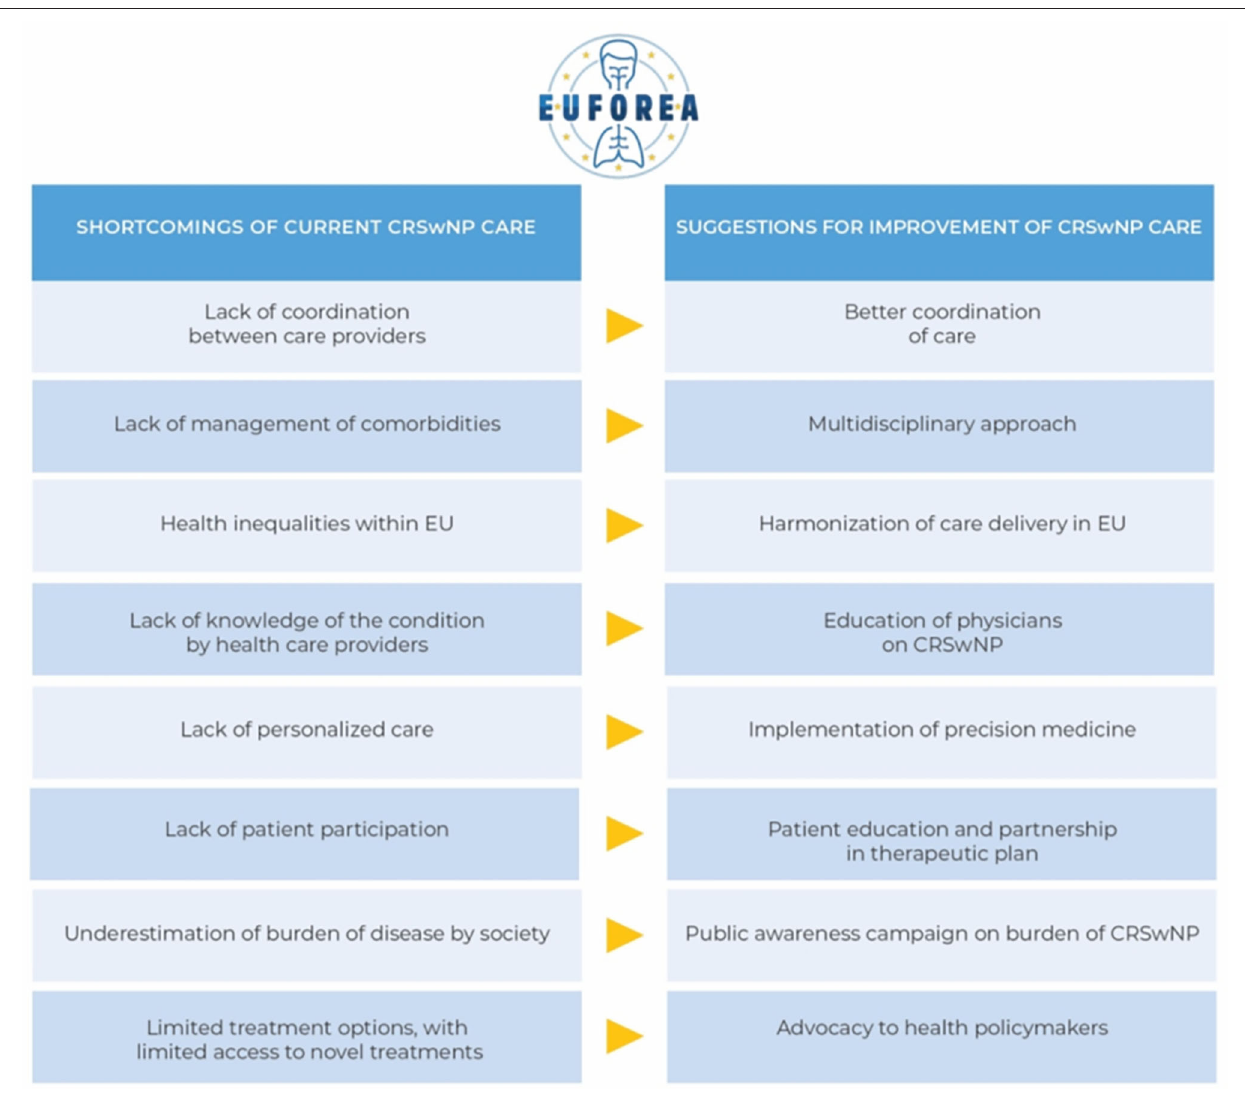
symptoms include nasal congestion, nasal drainage and facial pressure